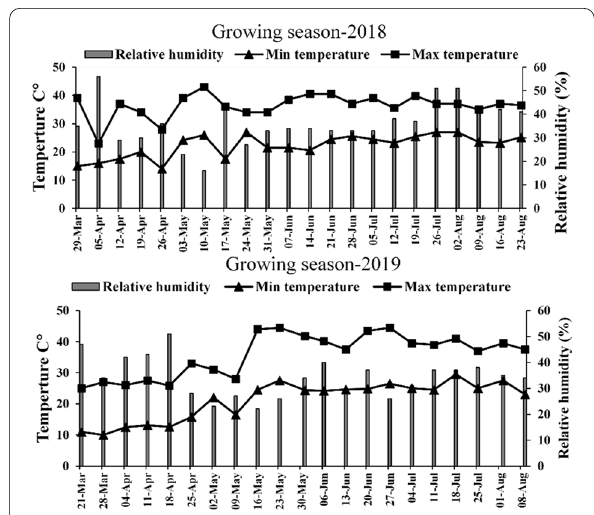
Fig. 1 Weather conditions during the two growing periods of Stevia cultivation